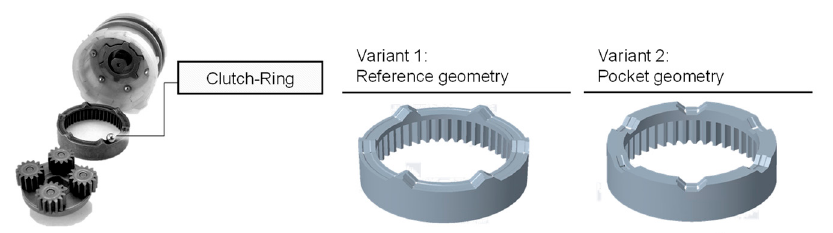
Figure 6. Differences in geometry for two different component variants of the clutch ring of a cordless screwdriver.